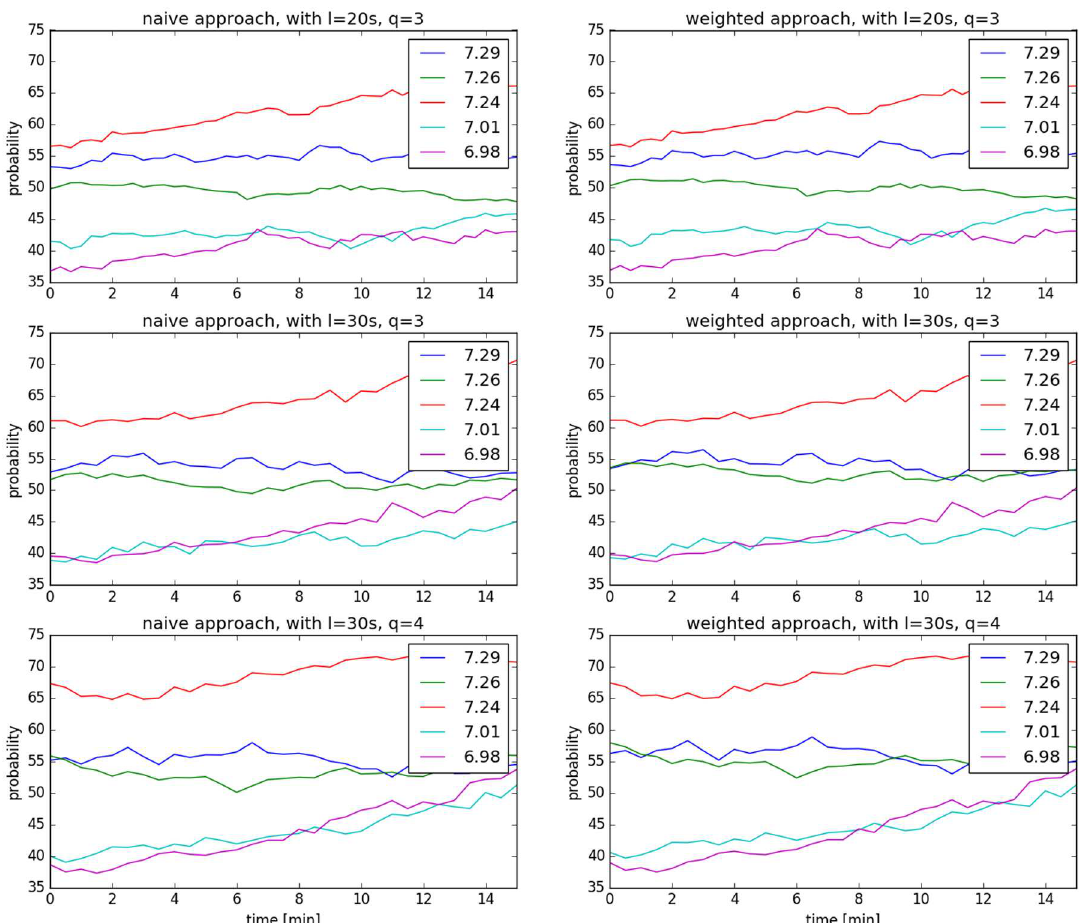
Fig 3. One instance of real-time classification results. The X axis representstime and the Y axis represents probability.